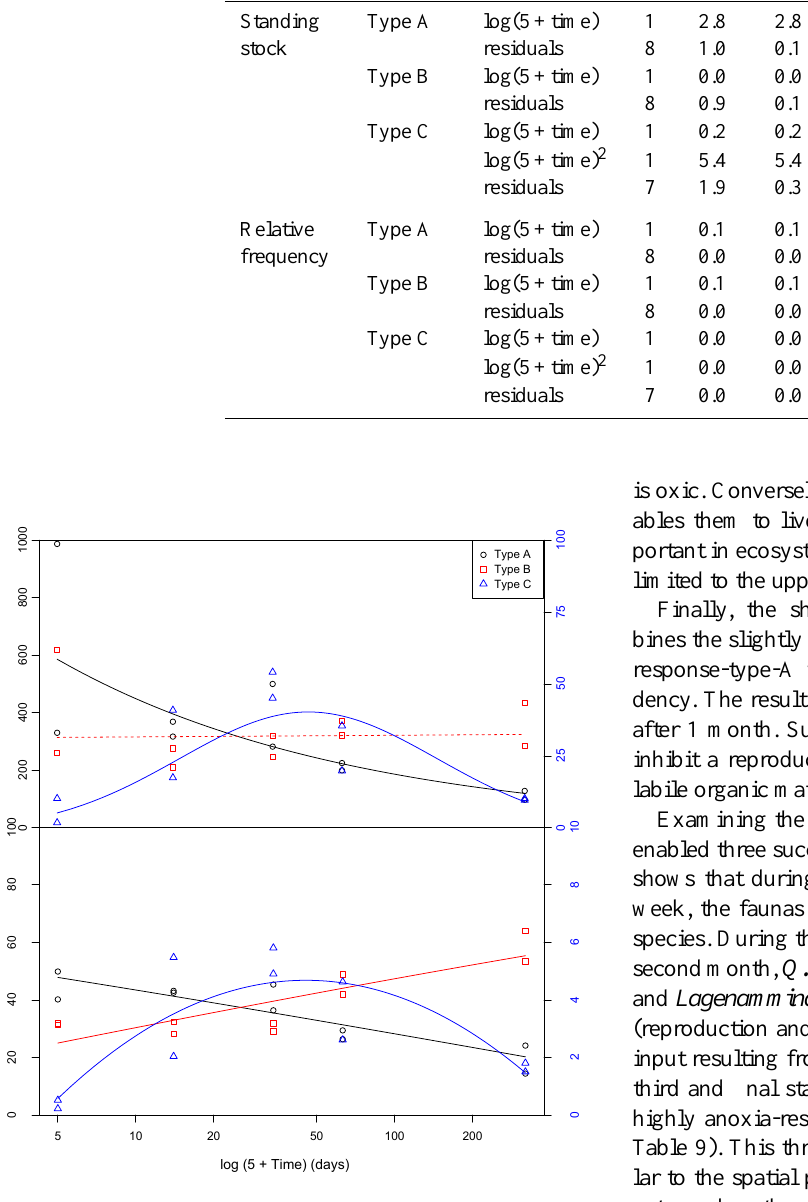
Fig. 6. Standing stock (upper panel) and relative density (lower panel) variation with time for the three types of response (black circles: type A; red squares: type B; and blue triangles: type C) in the whole core (0–5cm). Note that for representation purposes the standing stocks and relative density of type C were multiplied by 10 (refer to axis on the right). The lines are estimated after the model-type 3, with full lines indicating a significant effect of time and dashed lines a nonsignificant